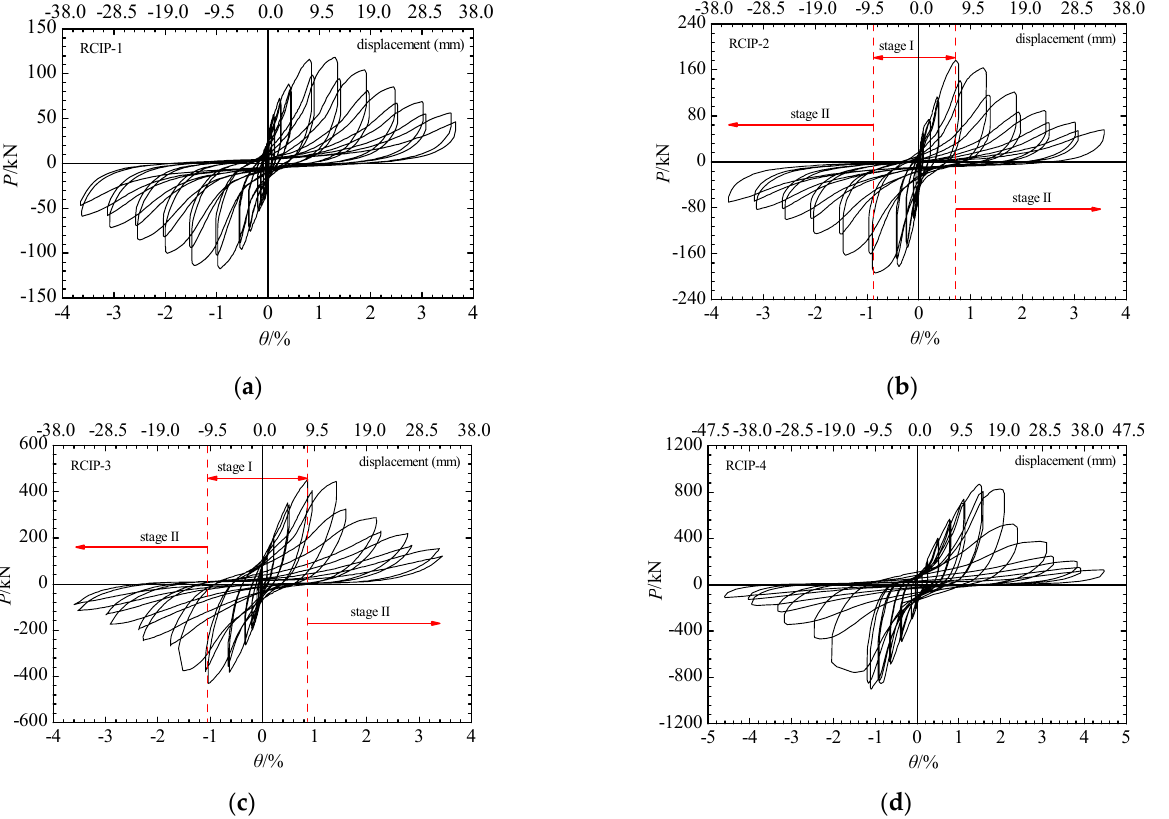
Figure 11. Hysteretic lateral load–drift ratio response of the tested specimens: ( a ) RCIP-1; ( b ) RCIP-2; ( c ) RCIP-3; ( d ) RCIP-4.